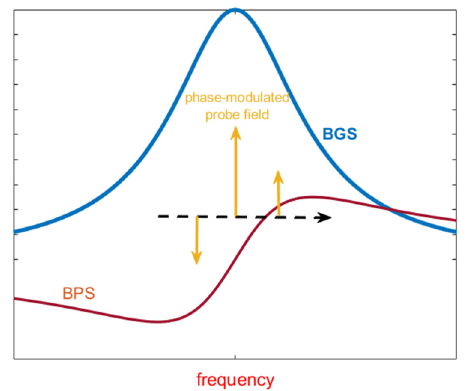
Figure 12. Schematic representation of the interactions involved in the heterodyne slope-assisted method [60]. The BGS and BPS affect both the carrier and the two first-order sidebands of the phase-modulated probe, leading to the appearance of an RF beat note on the transmitted probe intensity.